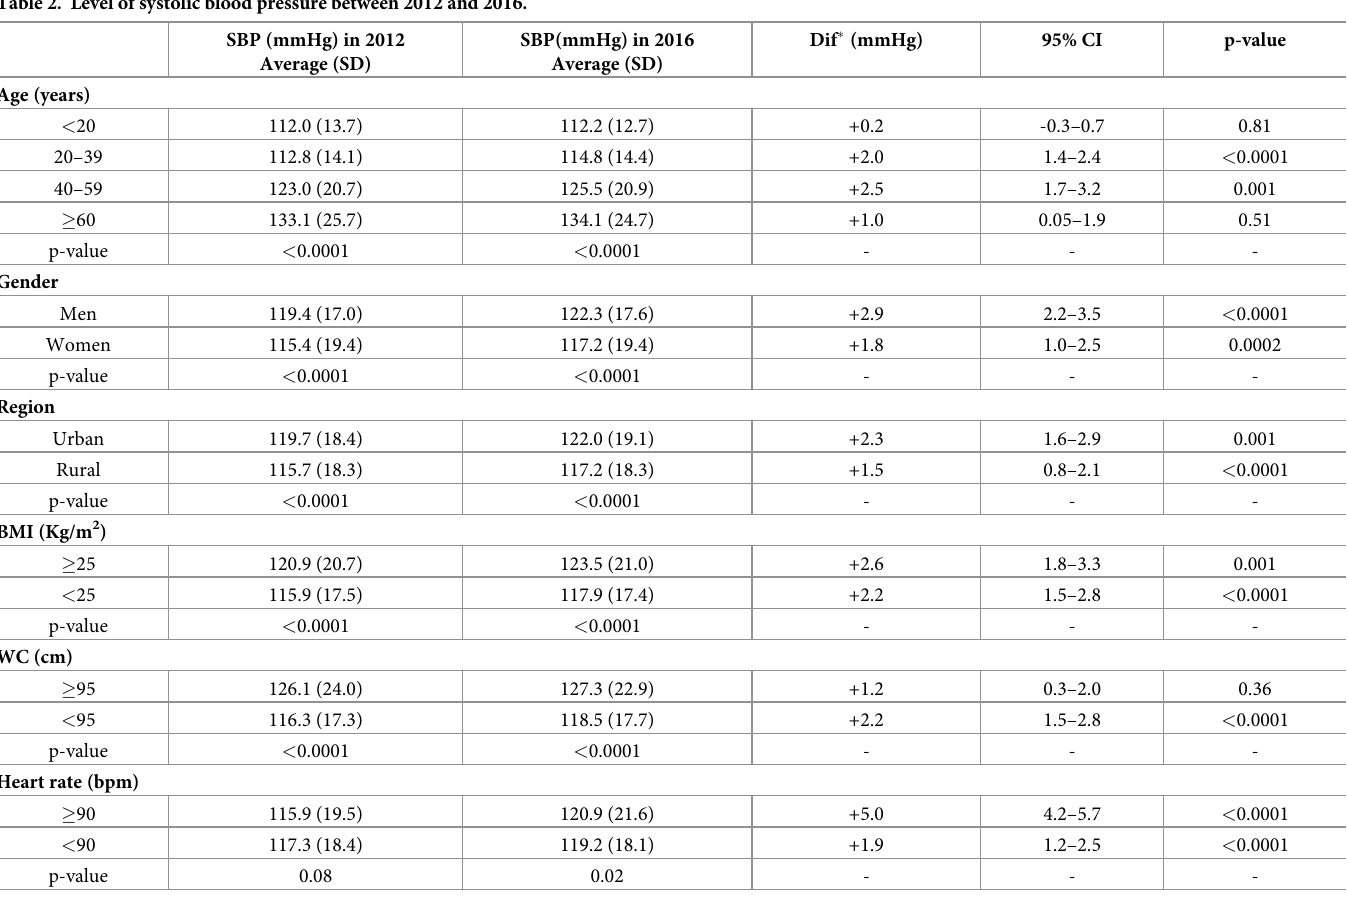
Table 2. Level of systolic blood pressure between 2012 and